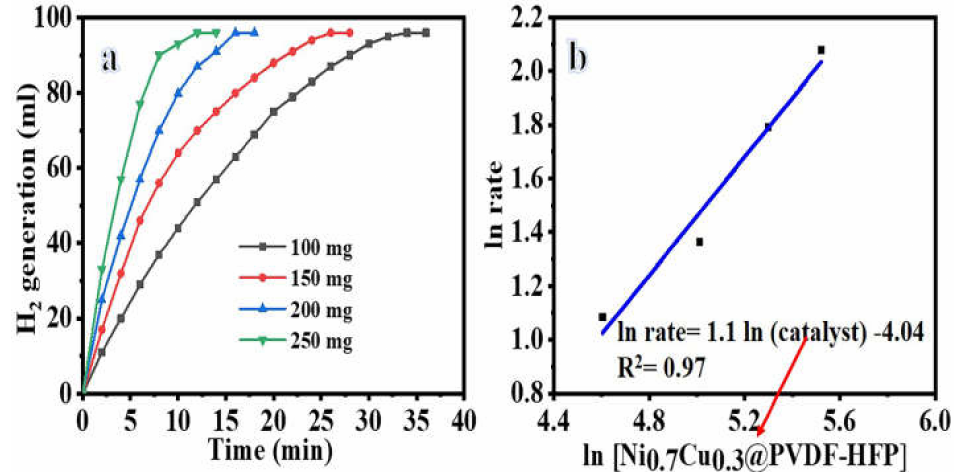
Figure 7. The effect of changing the amount of Ni 0.3 Cu 0.7 /PVDF-HFP NFs on H 2 production ( a ), and the H 2 production rate logarithmic value vs. at catalyst amount logarithmic value ( b ) at 1 mmol [SBH] and 298